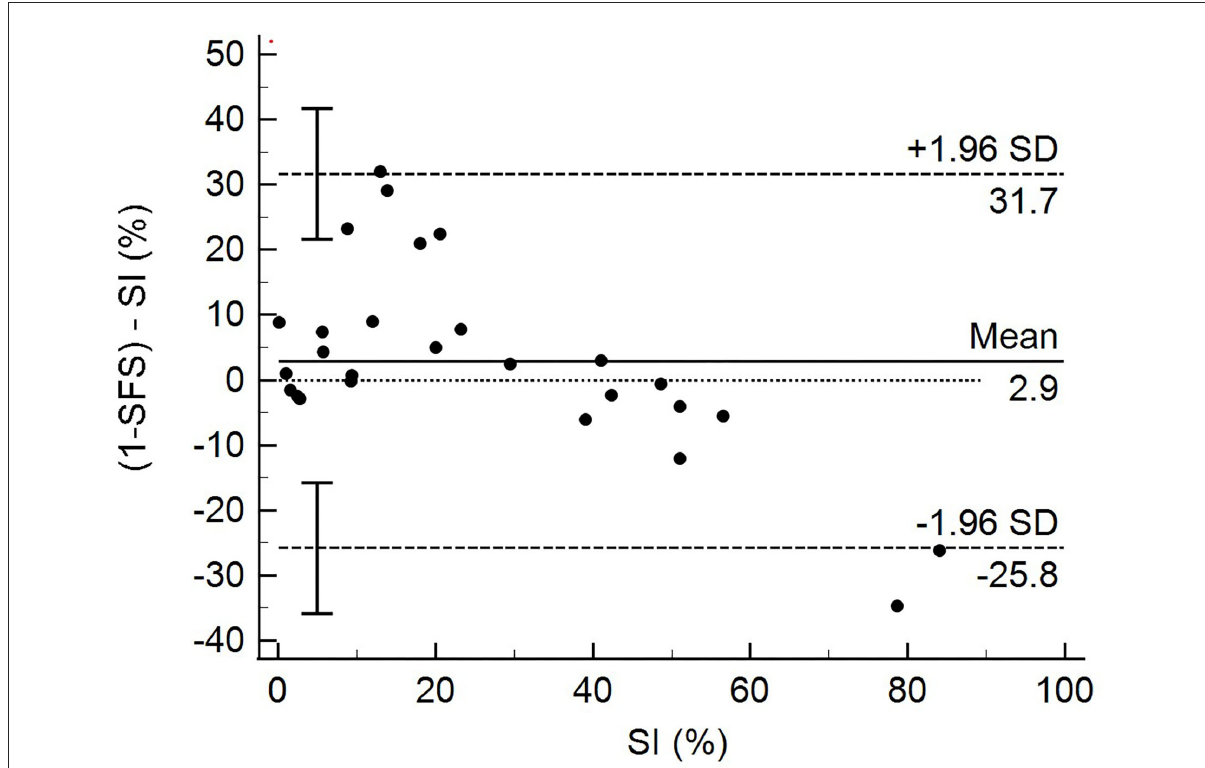
FIGURE2 Graphic representation of Bland-Altman plot between (1-SFS) - SI (%) and SI